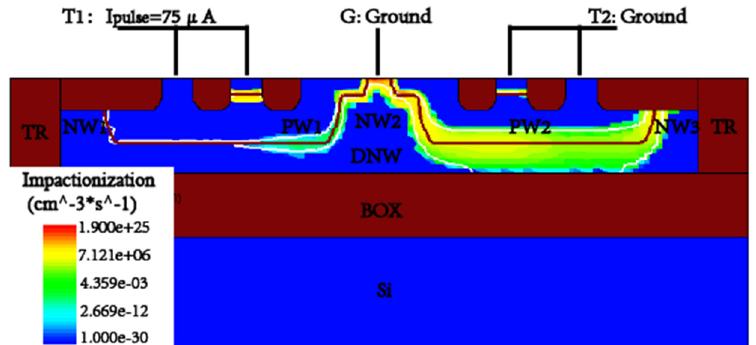
Figure 4. TCAD-simulated impact ionization rate distribution in PTBSCR (L = 0.5 μ m) when T1 is subject to the stress of I pulse = 60 μ A, T2 and G are grounded.